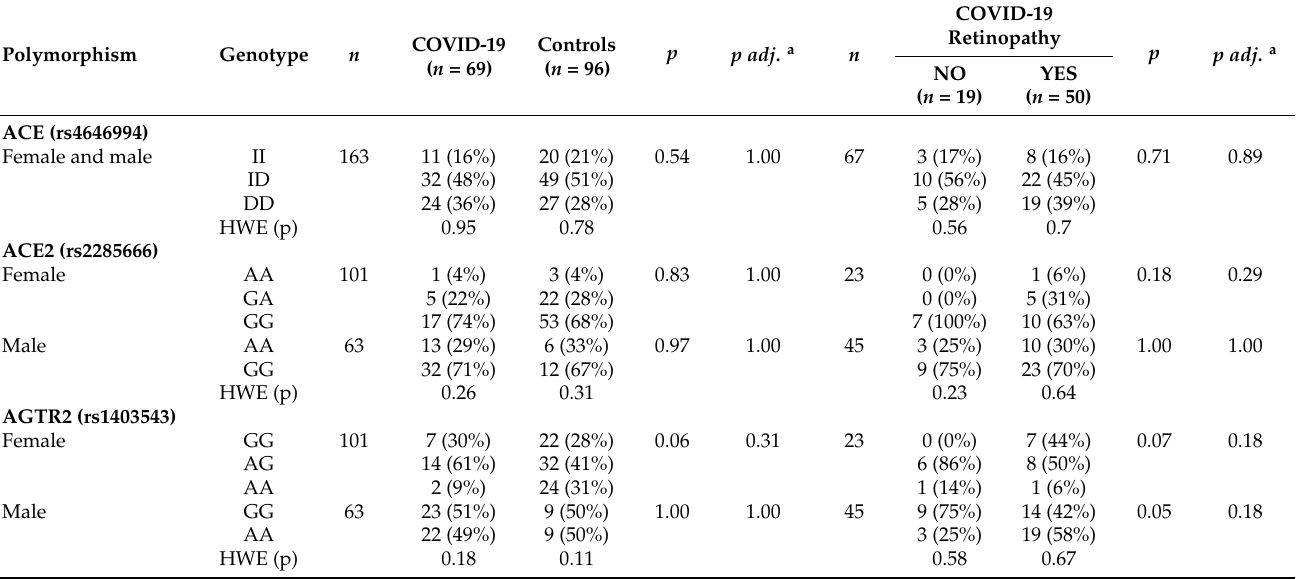
Table 3. The distribution of genotypes for ACE I/D, ACE2 rs2285666, and AGTR2 rs1403543 in the COVID-19 patients compared with healthy controls and based on the presence of COVID-19 retinopathy.